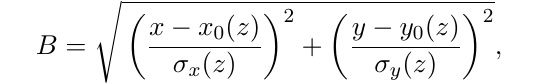
Figure 2 . Distributions of the beam variable B for K (cid:6) normalized MC samples. The simulated samples include signal and